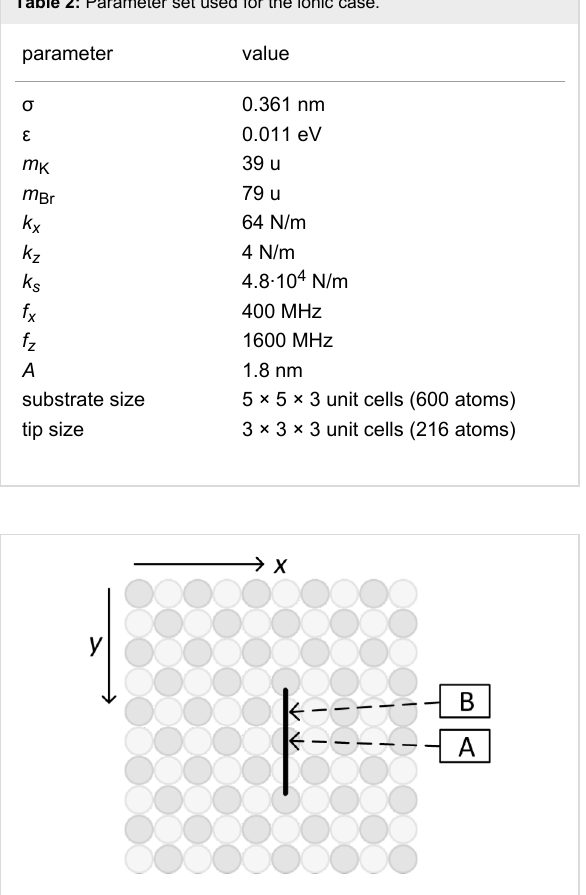
Figure 3: Top view of the substrate surface for the ionic crystal. Dis- tance dependence is probed at position A with oppositely charged apex and projection atom and at position B with same charges. Con- stant height scans are performed along the sketched